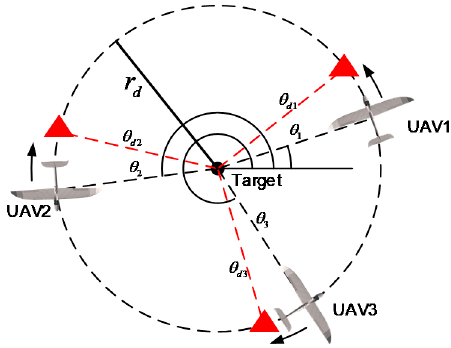
Figure 9. Cooperative target tracking using three unmanned aerial vehicles (UAVs).